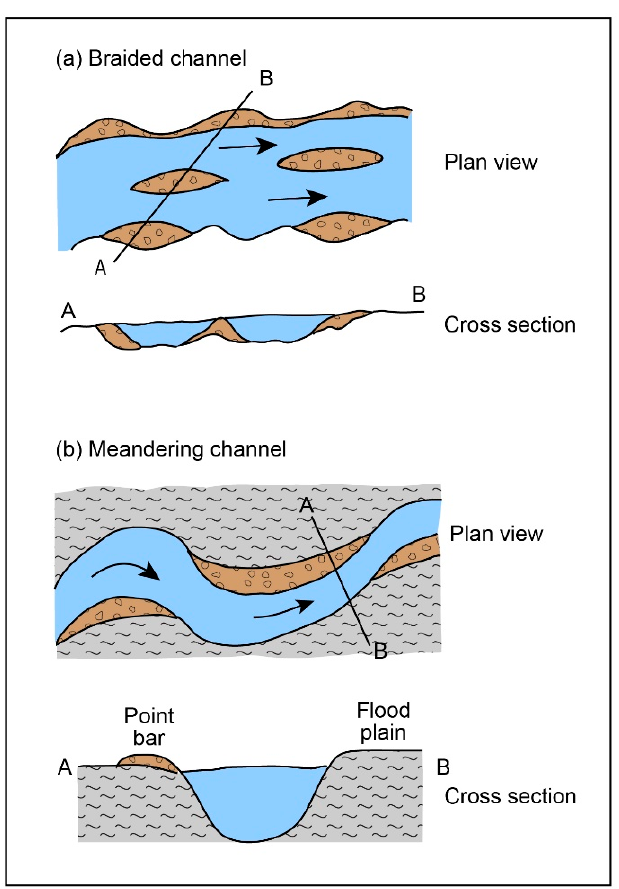
Figure 4. Channel plan form and cross section. ( a ) Braided channel. ( b ) Meandering channel. ( a ) is based on the author’s observations in the South Island of New Zealand; ( b ) is based on the author’s observation east of the lower White Nile, central Sudan.